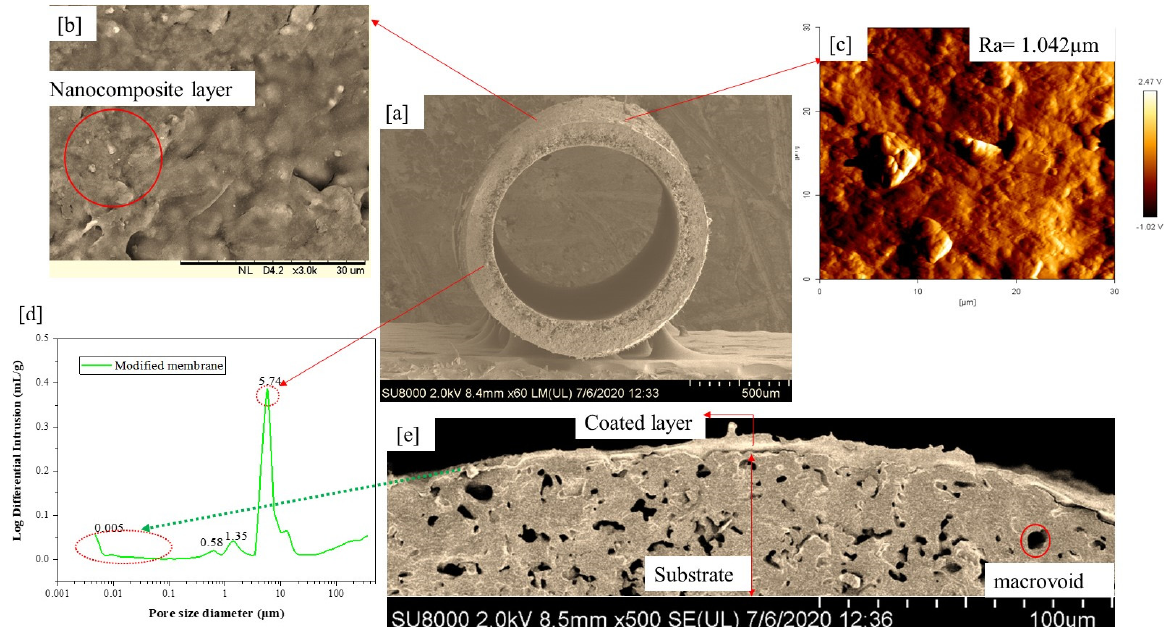
Figure 1. ( a , b , e ). FESEM cross-sectional image, ( b ) outer layer surface morphological images; ( c ) of the surface roughness topological image; ( d ) pore size distribution of the coaled layer of the hollow fiber ceramic membrane. Adapted from Ref. [50].